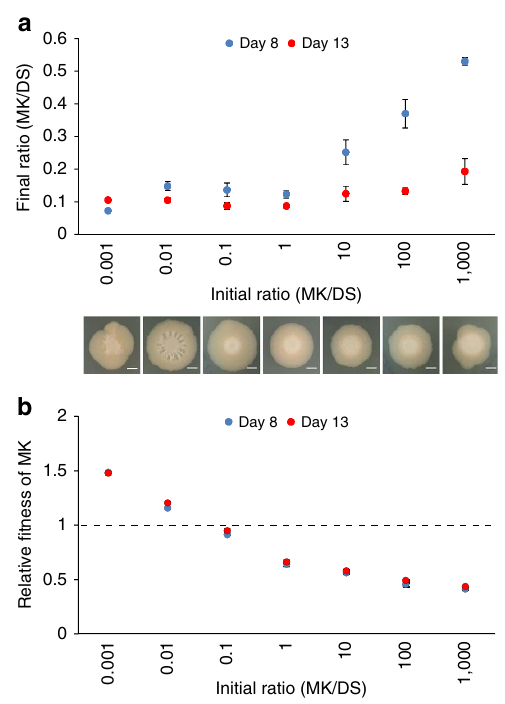
Figure 2 | The frequency of M and D morphotypes approach a characteristic ratio independent of the initial frequency. ( a ) The ratio of kanamycin-resistant M (MK) compared with streptomycin-resistant D (DS) in mixed colonies on day 8 (blue) and day 13 (red) plotted against the initial ratio. Shown below are corresponding images of mixed colonies on day 8. Scale bars, 5mm. ( b ) The data in a plotted as relative fitness of MK compared with DS. The dotted line represents equal fitness. All error bars represent the s.d. of the mean from three independent